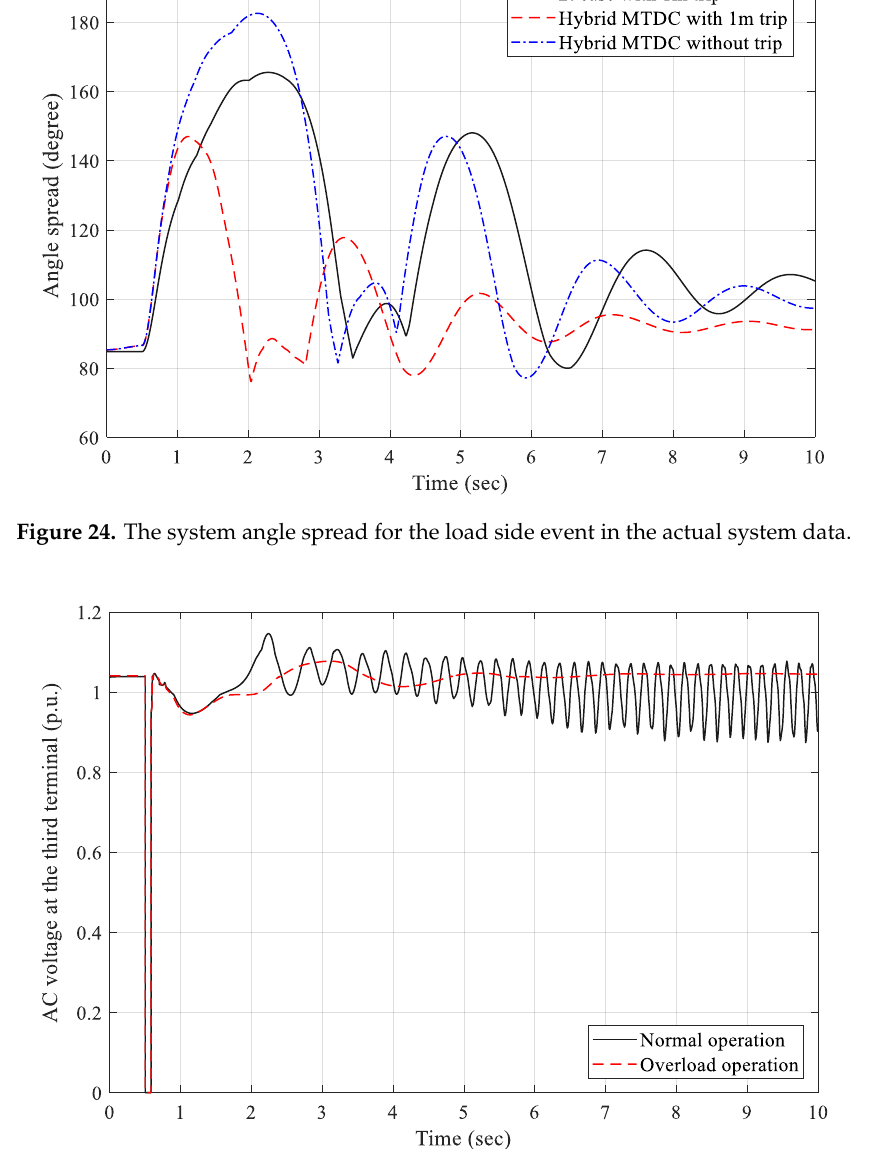
Figure 24. The system angle spread for the load side event in the actual system data.